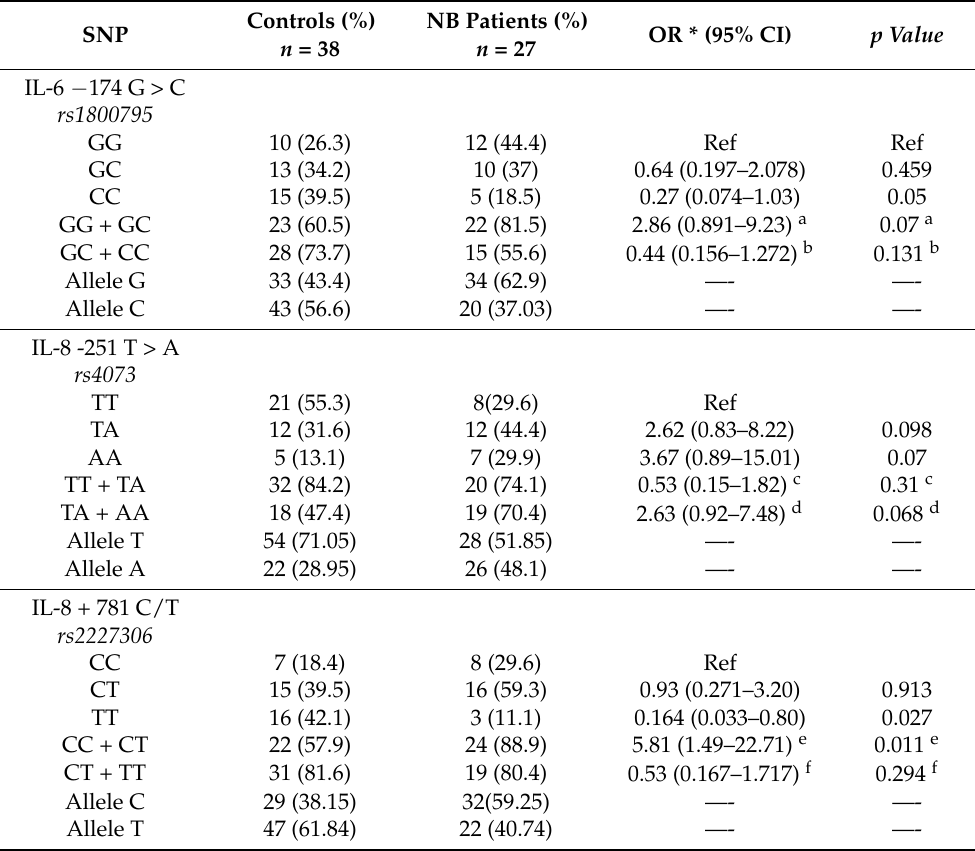
Table 2. Genotype frequencies of the interleukin IL-6 rs1800795, IL-8 rs4073/rs2227306 in NB patients and